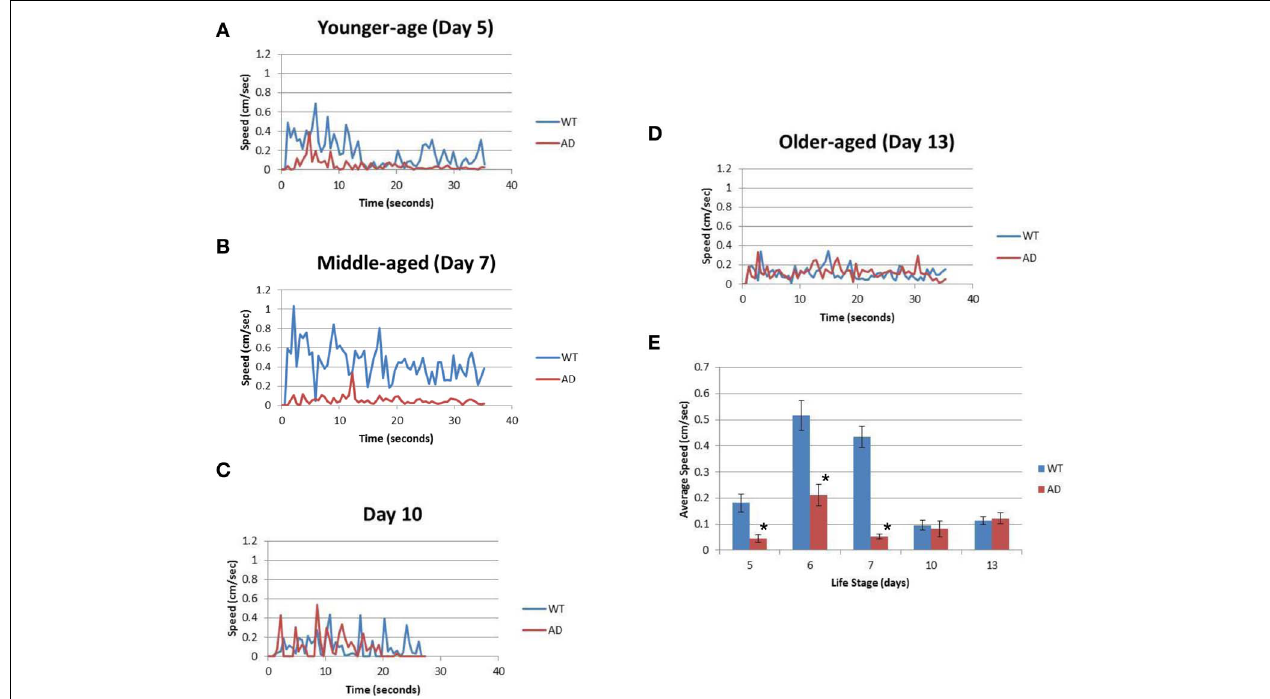
FIGURE 2 | The AD strain exhibits slower speeds than WT in the life cycle. (A) The graph represents the locomotion speed of adult worms measured at the age of day 5 (younger age). (B) The graph represents the speed for worms measured at the age of day 7 (middle age). (C) The graph represents the speed for middle-aged worms measured at the age of day 10.